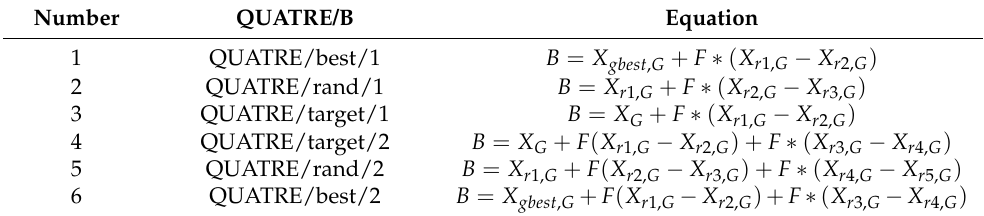
Table 1. The six schemes of Matrix B calculation in QUATRE